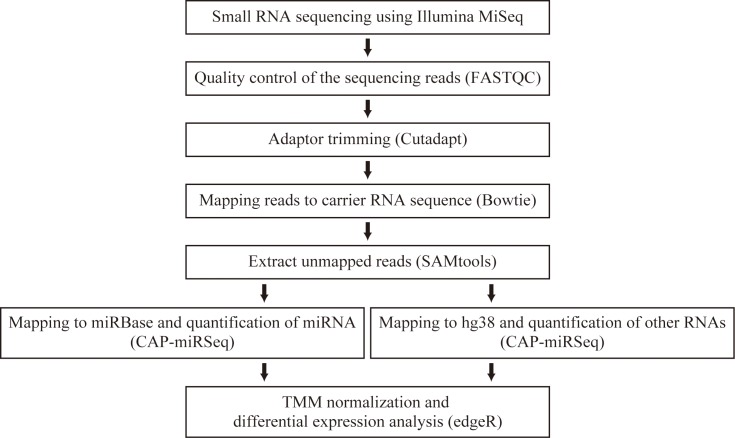
Flowchart of data analysis.After a quality check and adaptor trimming, the elimination of carrier RNA-Seq reads was performed using these bioinformatics tools. Thereafter, CAP-miRSeq was used to perform mapping and read counts. Differential expression analysis was conducted with edgeR. The software programs used for analysis are shown in parentheses.